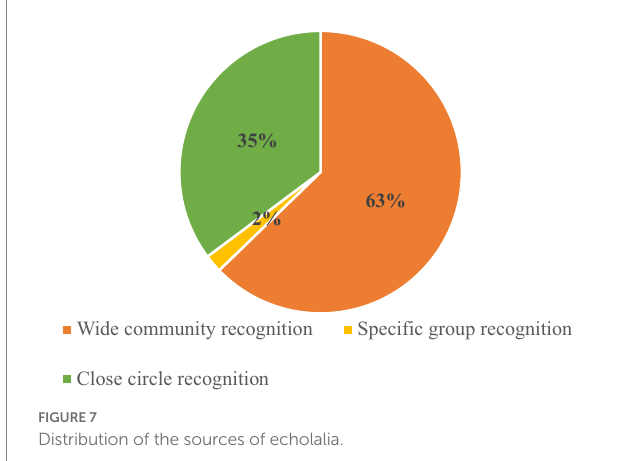
FIGURE 5 Distribution of immediate vs. delayed echolalia.